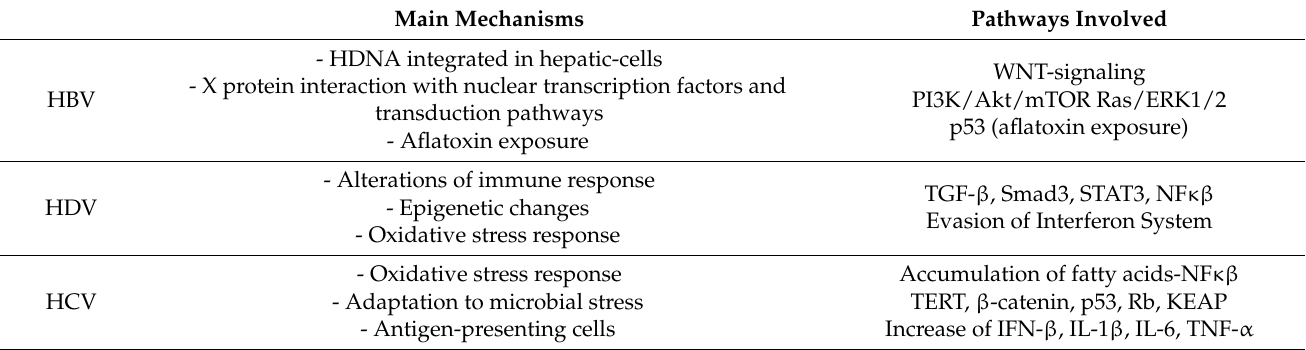
Table 1. Mechanisms of hepatic carcinogenesis in patients with chronic viral infection. Main